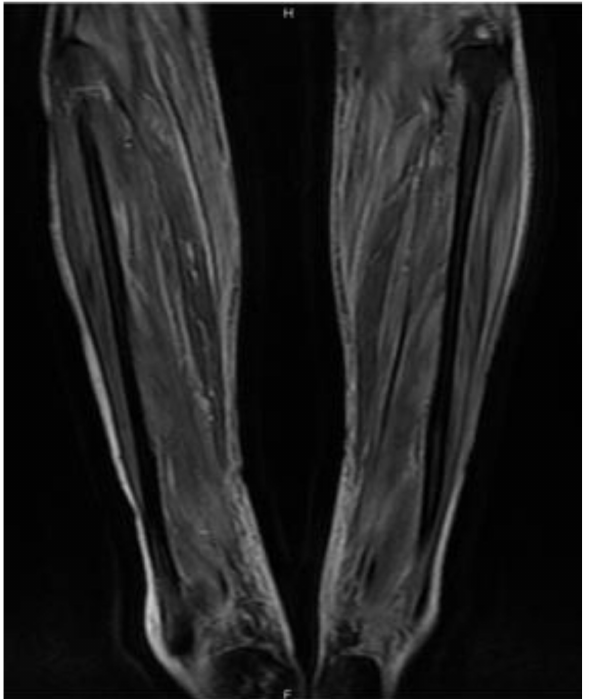
Figure 3. Magnetic resonance imaging of the lower leg revealed inflammation of the muscle in short T1 inversion